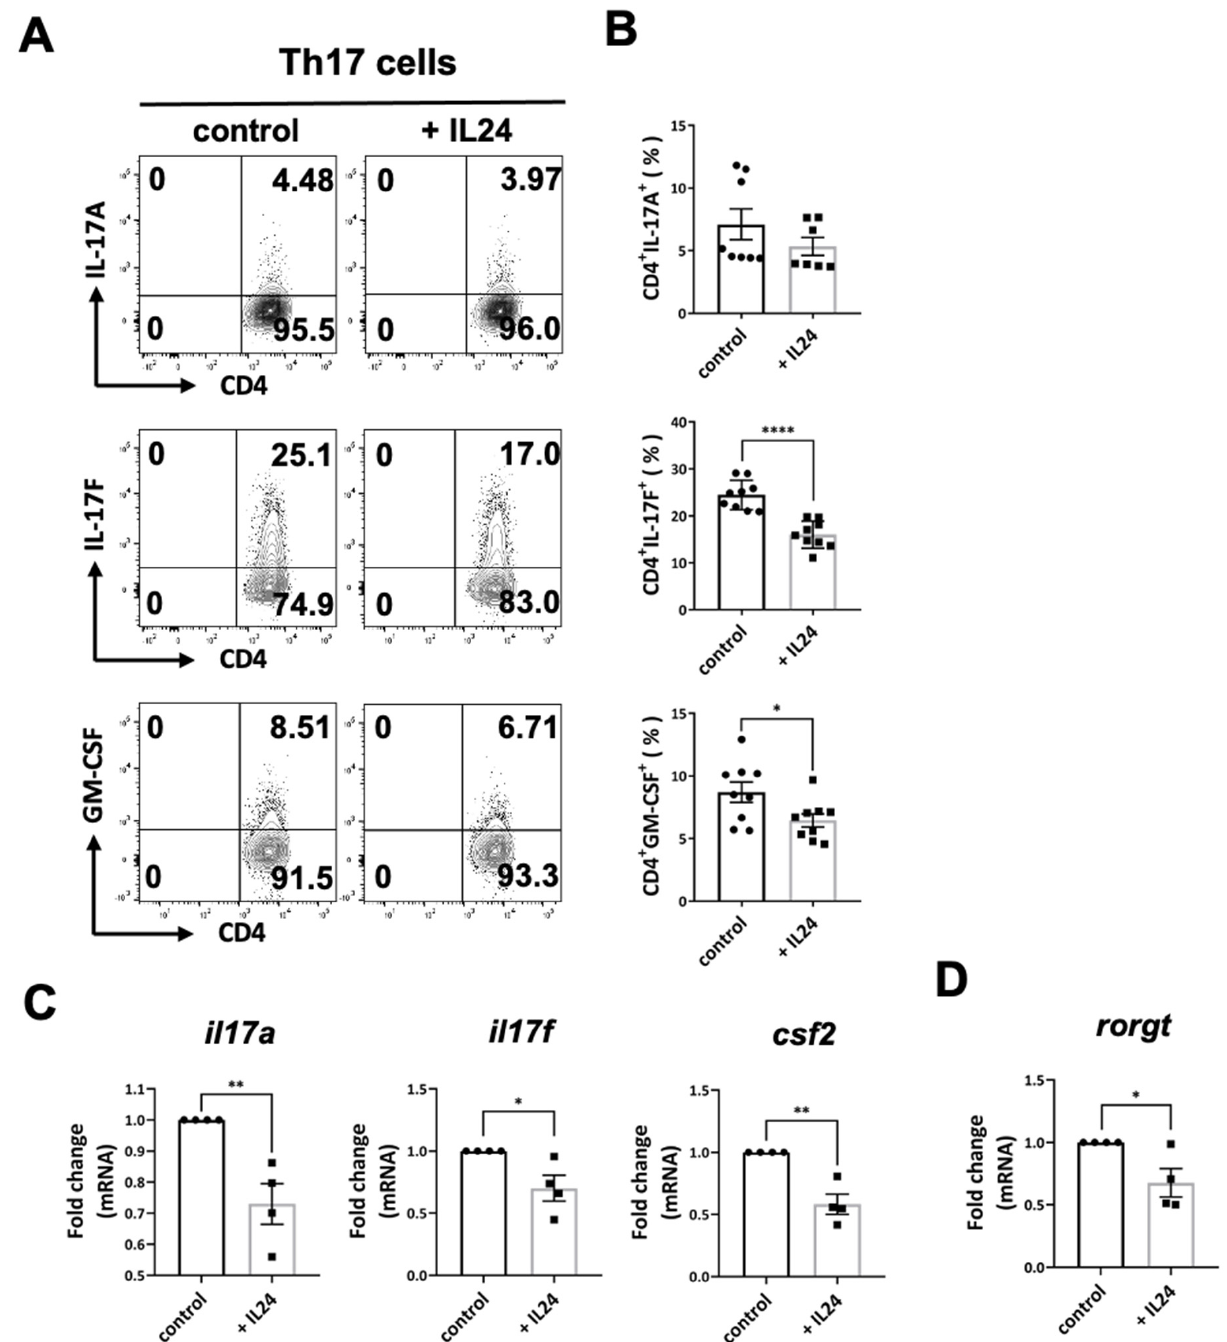
Figure 2. IL-24 inhibited Th17 cells. CD4 + CD62L + T cells from spleens and LNs of C57BL/6 mice were isolated and polarized under Th17 conditions with anti-CD3/CD28 antibodies for 3 days, with and without recombinant IL-24. ( A , B ) Representative FCM plots ( A ) and compiled data ( B ) of IL-17A, IL-17F, and GM-CSF expression in Th17 cells. Data represent means ± SEMs of three independent experiments. * p < 0.05, **** p < 0.0001, Student’s t test. ( C , D ) The relative gene expression of IL17A, IL17F, CSF2, and ROR γ t in Th17 cells. Data represent means ± SEMs of 4 independent experiments. * p < 0.05, ** p < 0.01, Student’s t test.